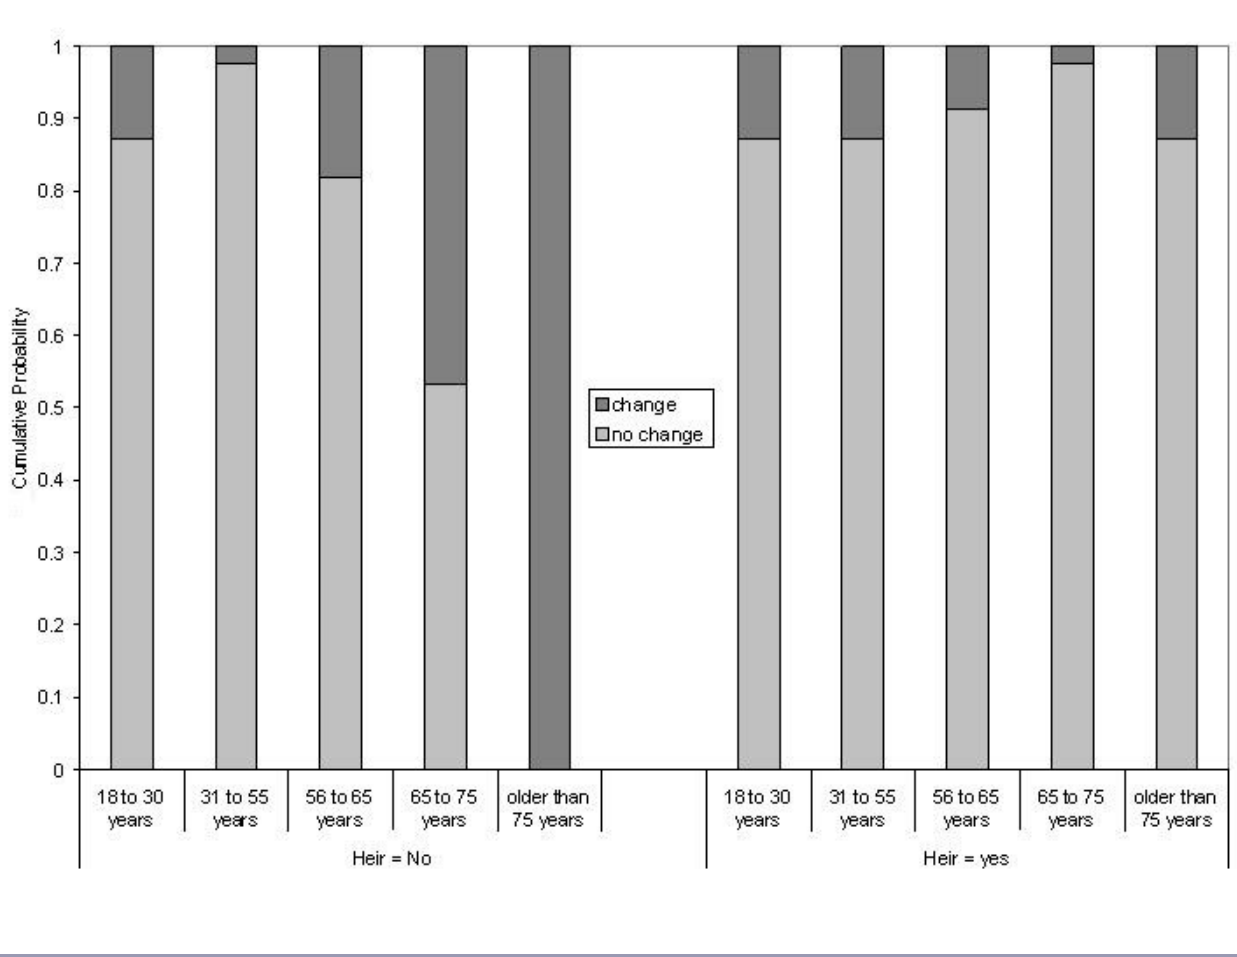
Fig. 6. Probability of change/no change in land cover for a land manager’s age and